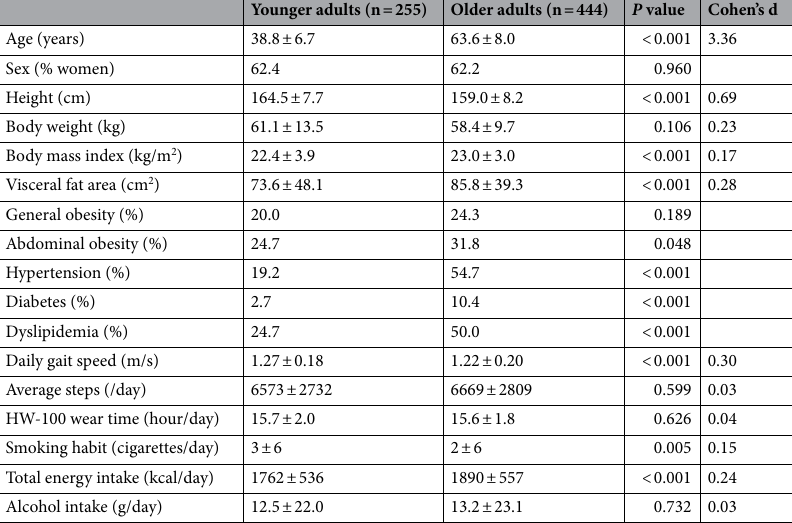
Table 1. Participant characteristics stratified based on age group. Values are the mean ± SD or percentages. Mann–Whitney U tests were used for continuous variables and Chi-square tests were used for categorical variables.